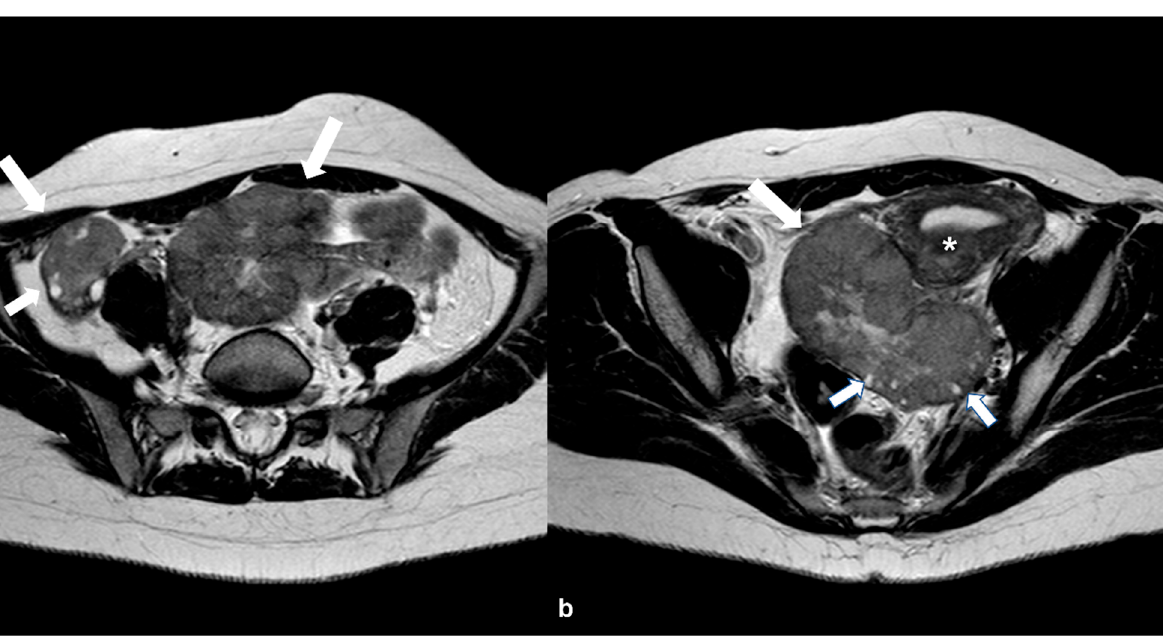
Figure 15. Primary ovarian lymphoma . Axial T2 weighted images ( a , b ) show bilateral ovarian enlargement (long arrows) with abnormal stromal signal intensity and peripheral displacement of the ovarian follicles (short arrows). The uterus is displaced to the left side of the pelvis by the enlarged left ovary (asterisk in ( b )).